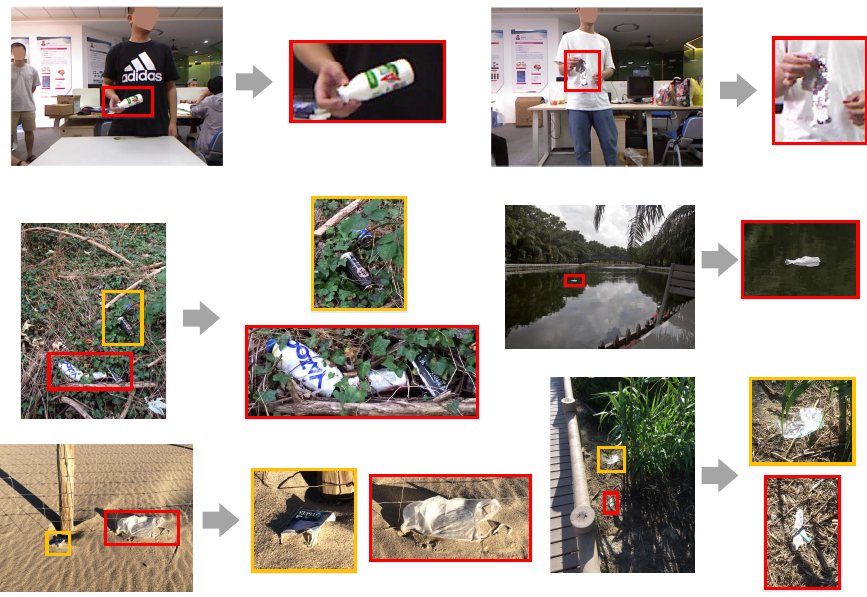
Figure 1. Example images from MJU-Waste and TACO [5] datasets and their zoomed-in object regions. Detecting and localizing waste objects require both scene level and object level reasoning. See text for